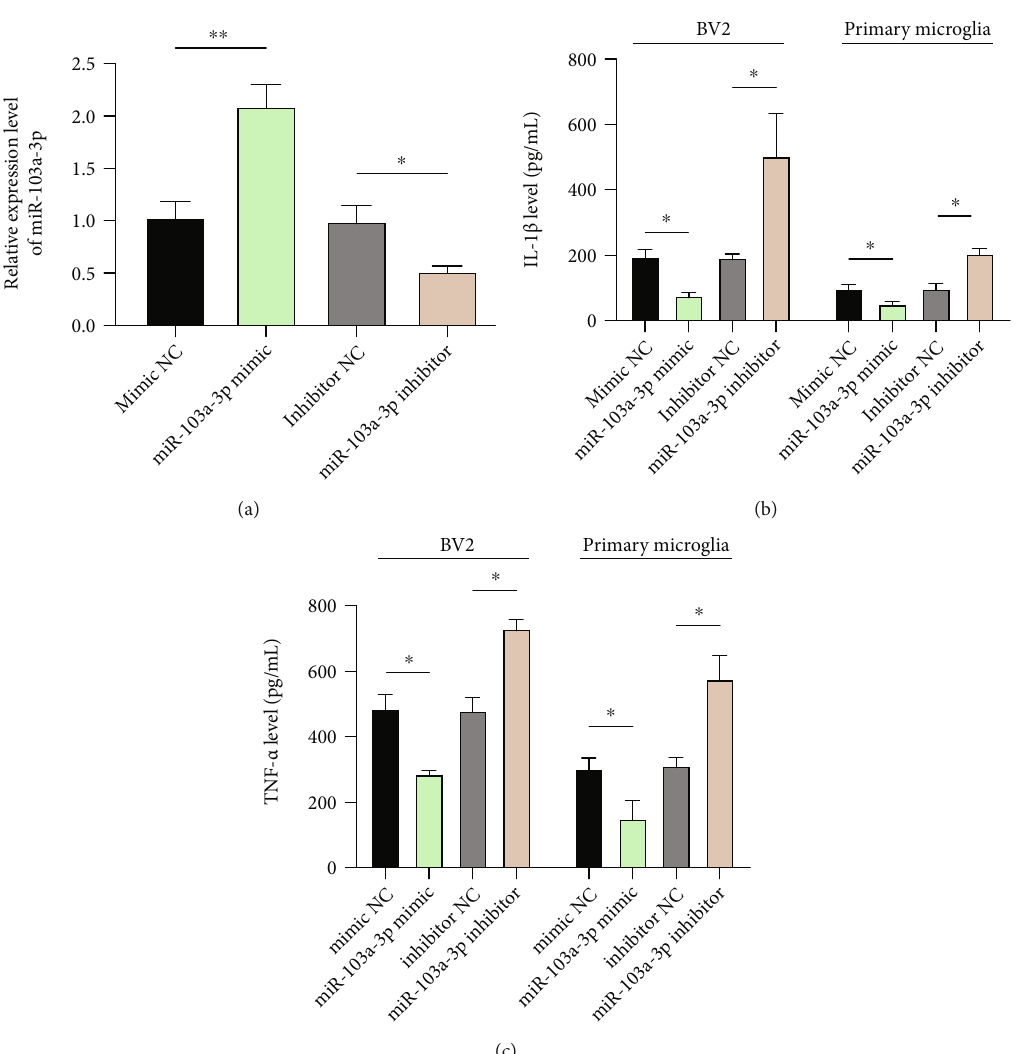
Figure 2: miR-103a-3p is important for microglial activation in BV-2 cells and primary microglia. (a) Synthesized miR-103a-3p mimics and inhibitors were transfected in BV-2 cells, and the miR-103a-3p expression level was then detected by qRT-PCR (with inhibitor NC or mimic NC as controls). Cells were transfected with miR-103a-3p mimics and inhibitors for 12h, and then treated with LPS for 6h. IL-1 β (b) and TNF- α (c) levels were then determined with an ELISA ( n =3, number of repeated experiments). Two tailed t -test, ∗ p < 0 : 05 , ∗∗ p < 0 : 01